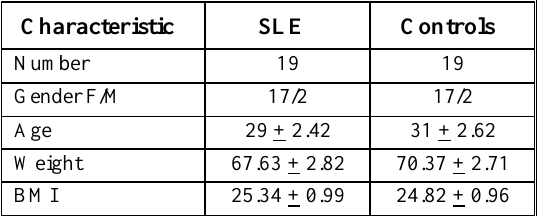
Table 1: Demographic data of the studied